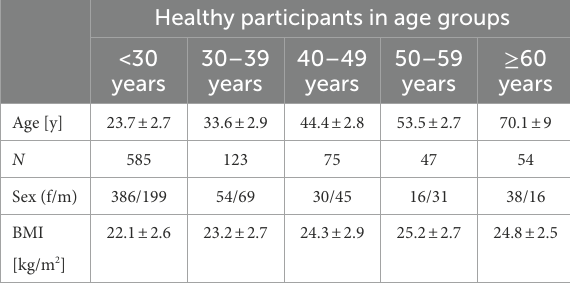
TABLE 3 Sample description in different age ranges.